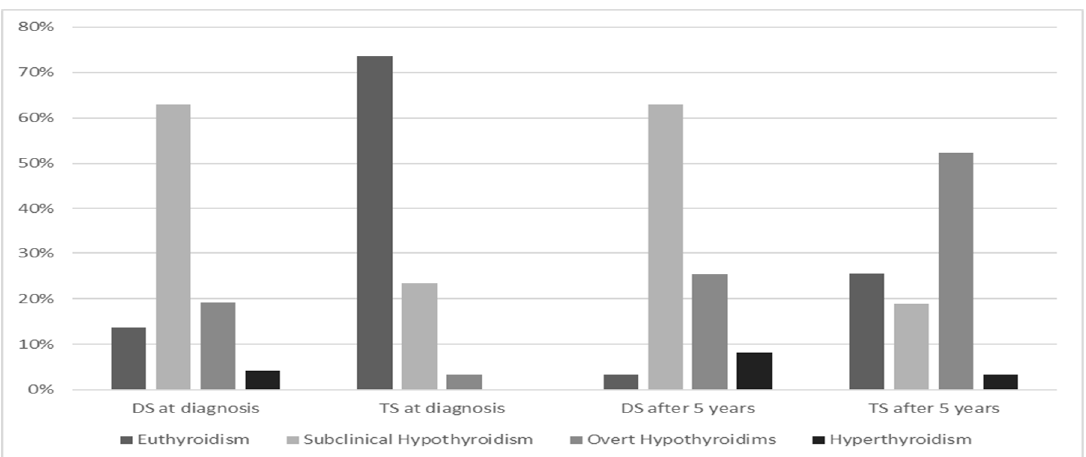
Figure 2. Hashimoto’s thyroiditis presentation pattern and evolution after 5-year follow-up in Turner syndrome (TS) and Down syndrome (DS), according to references [67,72].